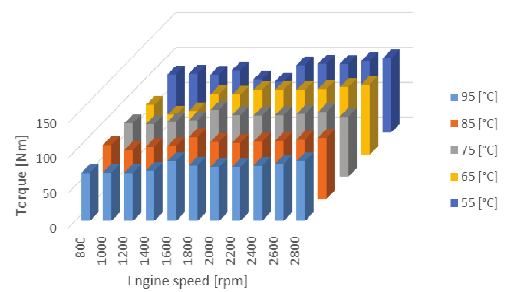
Fig. 11. Oil system power [8]